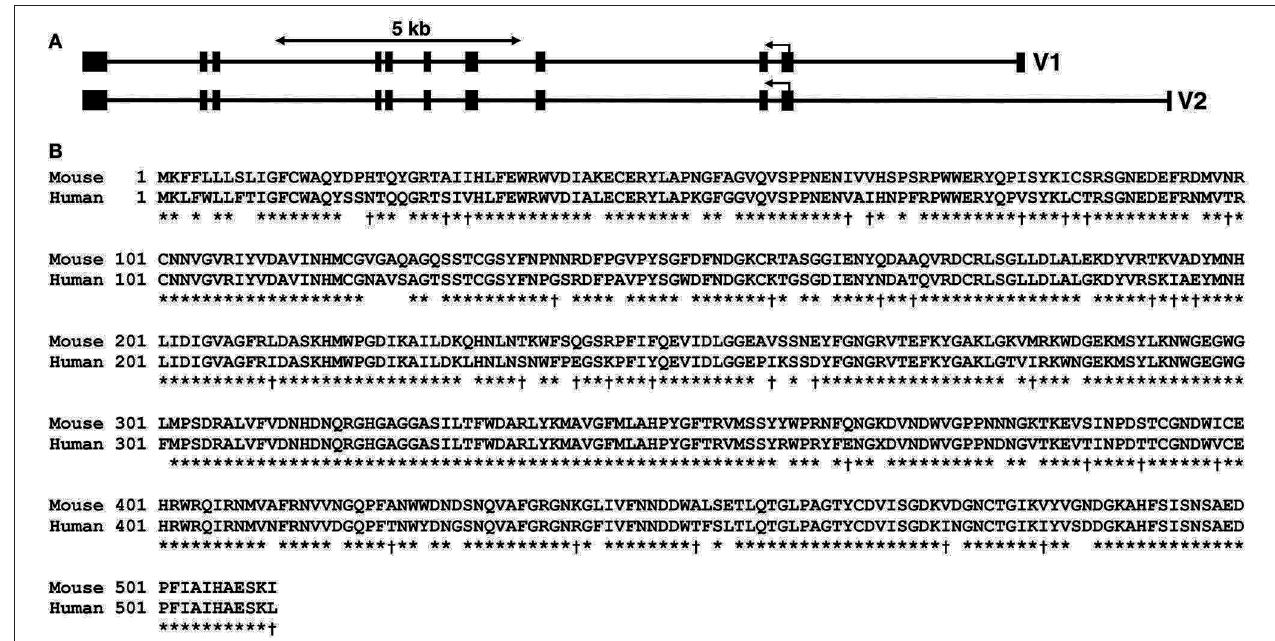
FIGURE 1 | Amy1 genomic organization in mice and comparison of murine with human salivary α -amylase protein sequences. (A) Genomic organization of the murine Amy1 gene along the negative strand of mouse chromosome 3. The two transcripts, variant 1 ( V1 , NM_007446.2) and variant 2 ( V2 , NM_001110505.1), are each encoded by unique first untranslated exons, but share the same ten 3 ′ -exons. The translation start codon is within exon 2, which encodes the first 56 residues including the signal peptide of 15 residues. Both transcripts thus encode the same protein. (B) ClustalW alignment of mouse Amy1 (NP_001110505.1) and human AMY1 (NP_004029.1) protein sequences. The gene products share 83.8% identity ( asterisk ) and an additional 6.4% similarity ( dagger ). The predicted signal peptide is indicated by the line (SignalP v5.0; Almagro Armenteros et al., 2019). The two genes are syntenic ( 3F3 , mouse; 1p21 , human). ClustalW pairwise parameters: open gap penalty, 10; extend gap penalty, 0.1; delay divergent, 40%; gap distance, 8; similarity matrix,